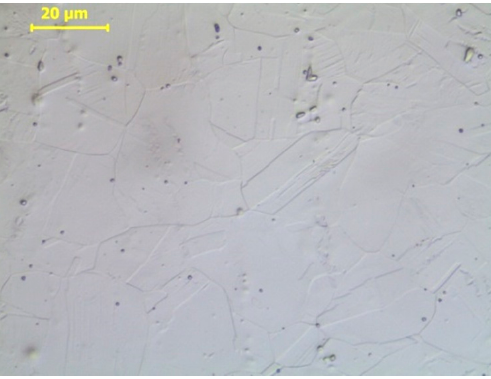
Figure 5. Austenitic structure of X2CrNi18-9 steel in the as-received state.